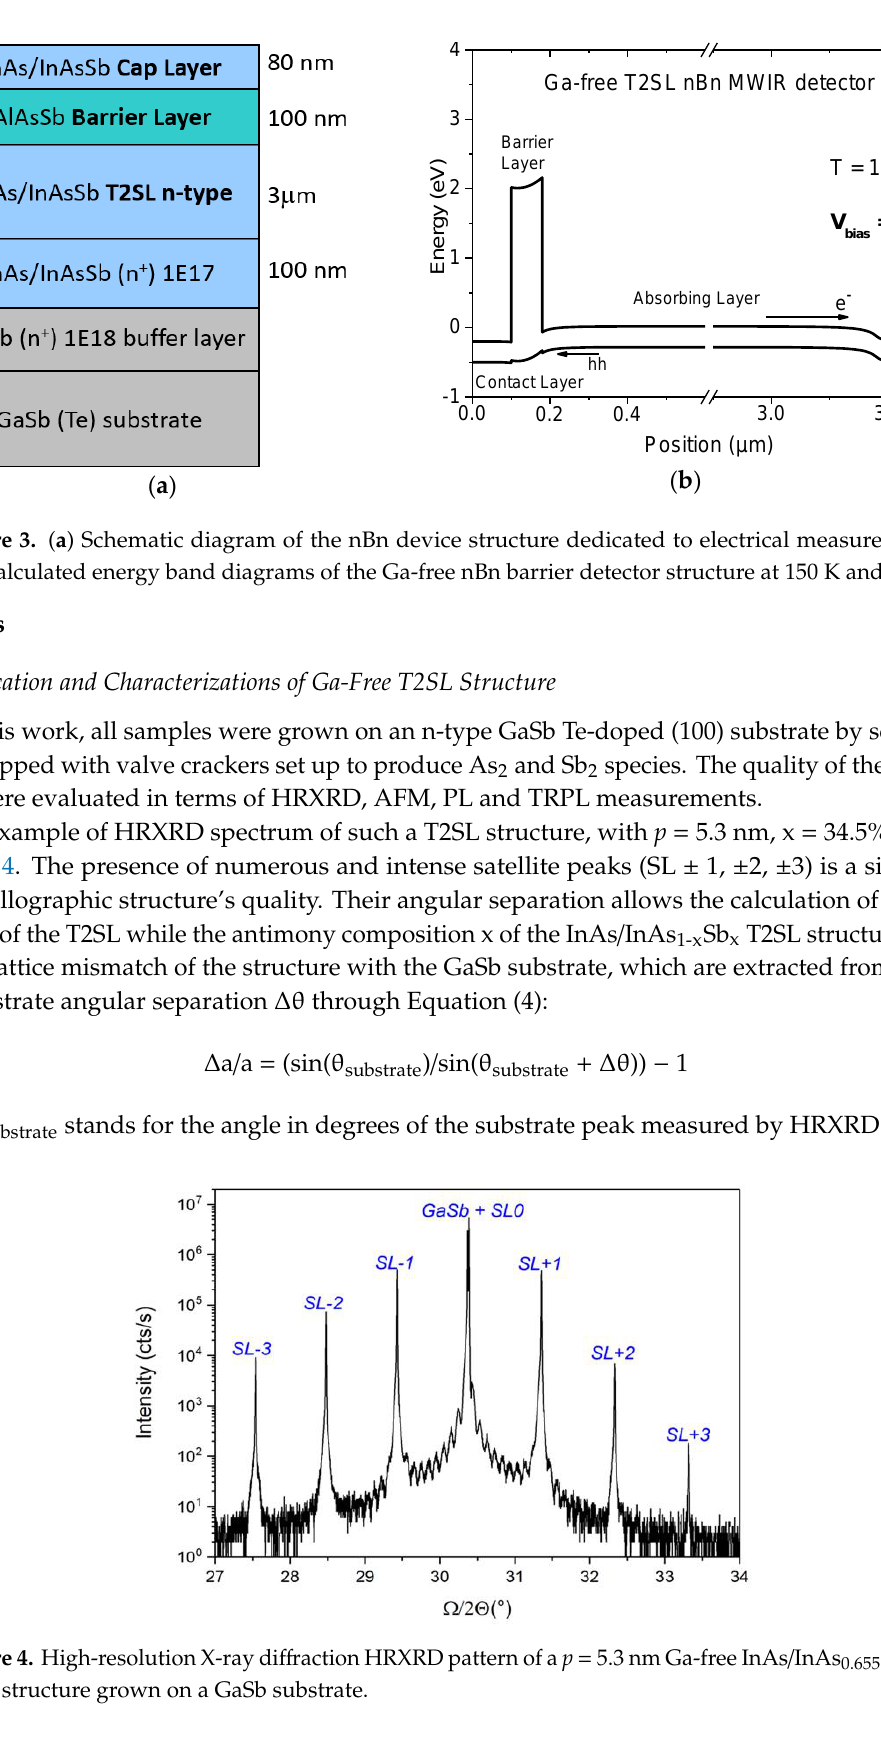
Figure 3. ( a ) Schematic diagram of the nBn device structure dedicated to electrical measurements. ( b ) Calculated energy band diagrams of the Ga-free nBn barrier detector structure at 150 K and 0 V.